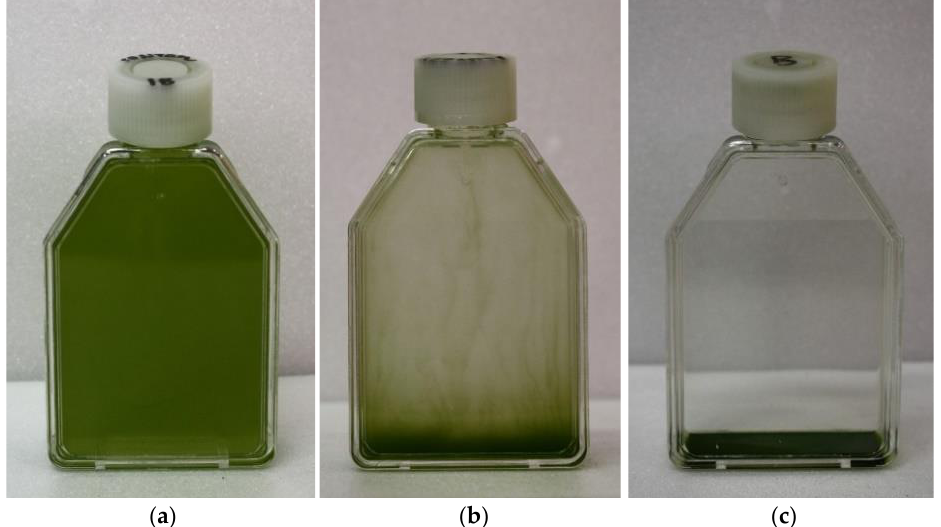
Figure 1. Picture of the settlement process under dark condition: ( a ) initial condition, ( b ) during settlement (on the 6th day), and ( c ) after settlement (on the 10th day).